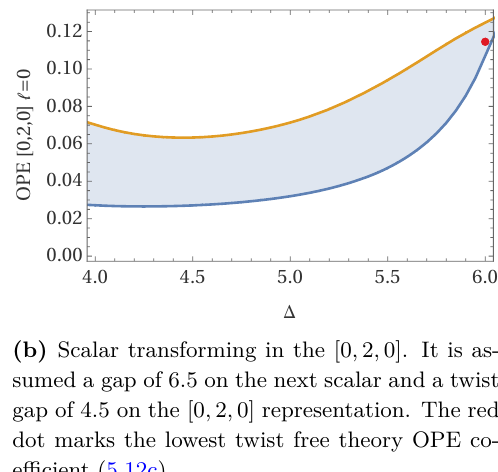
Figure 10. Upper and lower bounds of the OPE coefficient a ∆ ,‘ of the lightest scalar in a given representation. We fixed N = 20